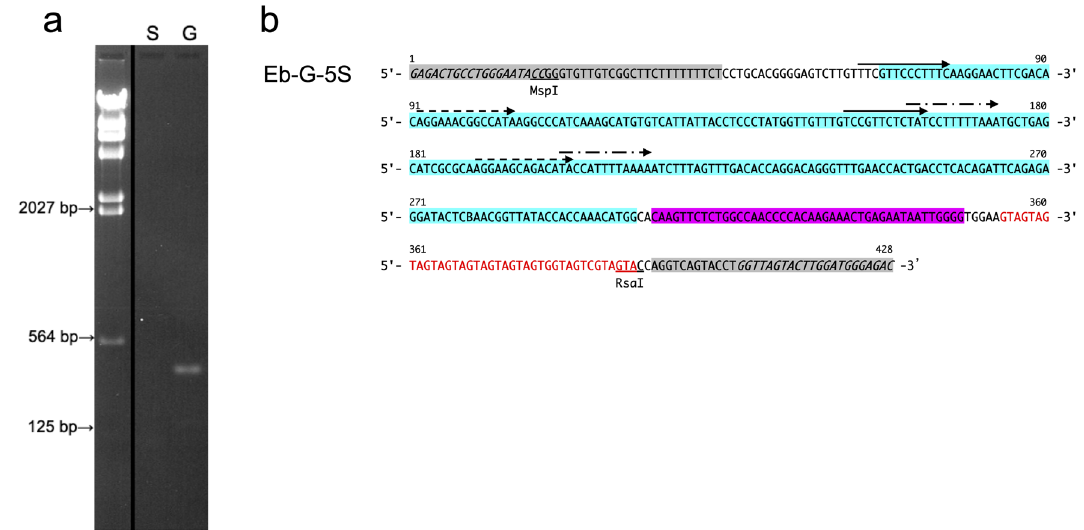
Figure 1. Amplification and consensus sequences of rDNA-related sequences. ( a ) PCR products using somatic DNA (lane S) and germline DNA (lane G) of the Japanese hagfish E. burgeri as templates were separated on a 1% agarose gel. The left lane in the photograph contains the DNA molecular size marker (Hind III-digested λ phage DNA). ( b ) The consensus nucleotide sequence was deduced from the inserts of germline genomic DNA clones. Gray shading: 5S rDNA, light-blue: SINE2-5_EBu, and purple: SINE2-6_EBu homologous regions. The GTA repeats detected are shown in red letters. Primer regions are indicated in italics. The direct repeats are marked with arrows. Recognition sites of each restriction endonuclease are underlined. The sequence data obtained here have been deposited in GenBank